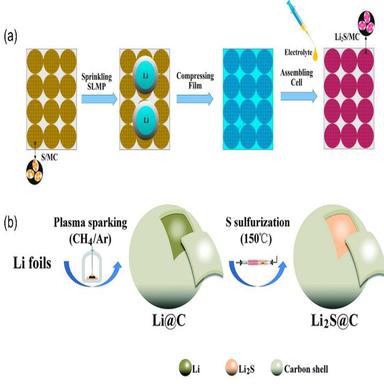
The schematic of (a) Li2S@MC electrodes and (b) Li2S@C by CVD . Reproduced from Refs. with permission from the American Chemistry Society and Royal Society of Chemistry.